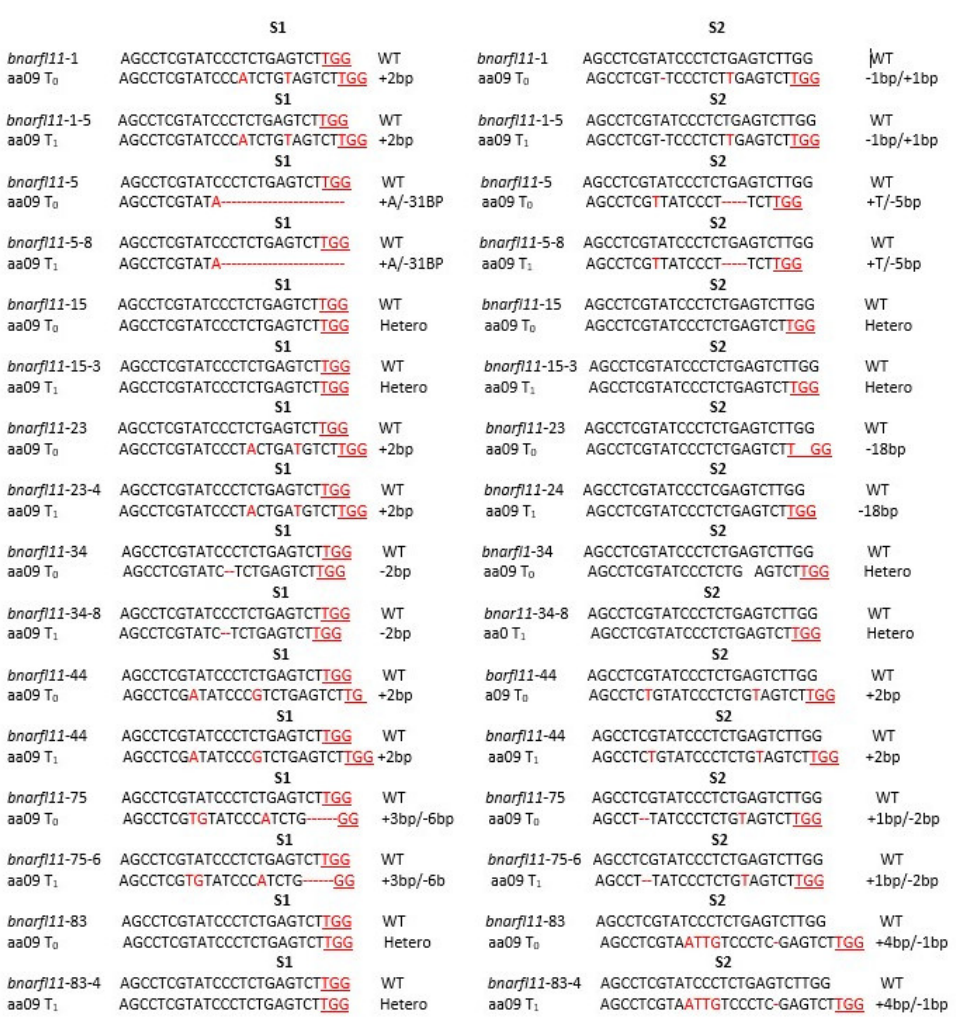
Figure 4. Mutation transmission from T 0 to T 1 generations. At both target sites in bnarfl11 mutant plants. Red font and red hyphens signify CRISPR-based alterations, whereas PAM is underlined and highlighted in red. The altered alleles of RFL11 on chromosome A were expressed as aa09. “−” and “+” signify losses.